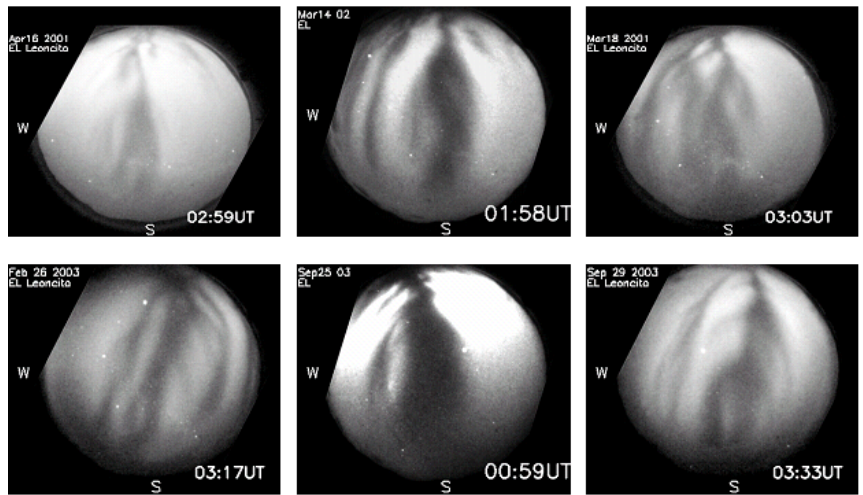
Fig. 2. El Leoncito 630.0nm images on six different nights showing typical airglow depletions throughout the night (LT ≈ UT–5). North is at the top and west to the left of each image. It is not rare to observe depletions leaving the southern FOV which, as shown in Fig. 1, have apex heights greater than